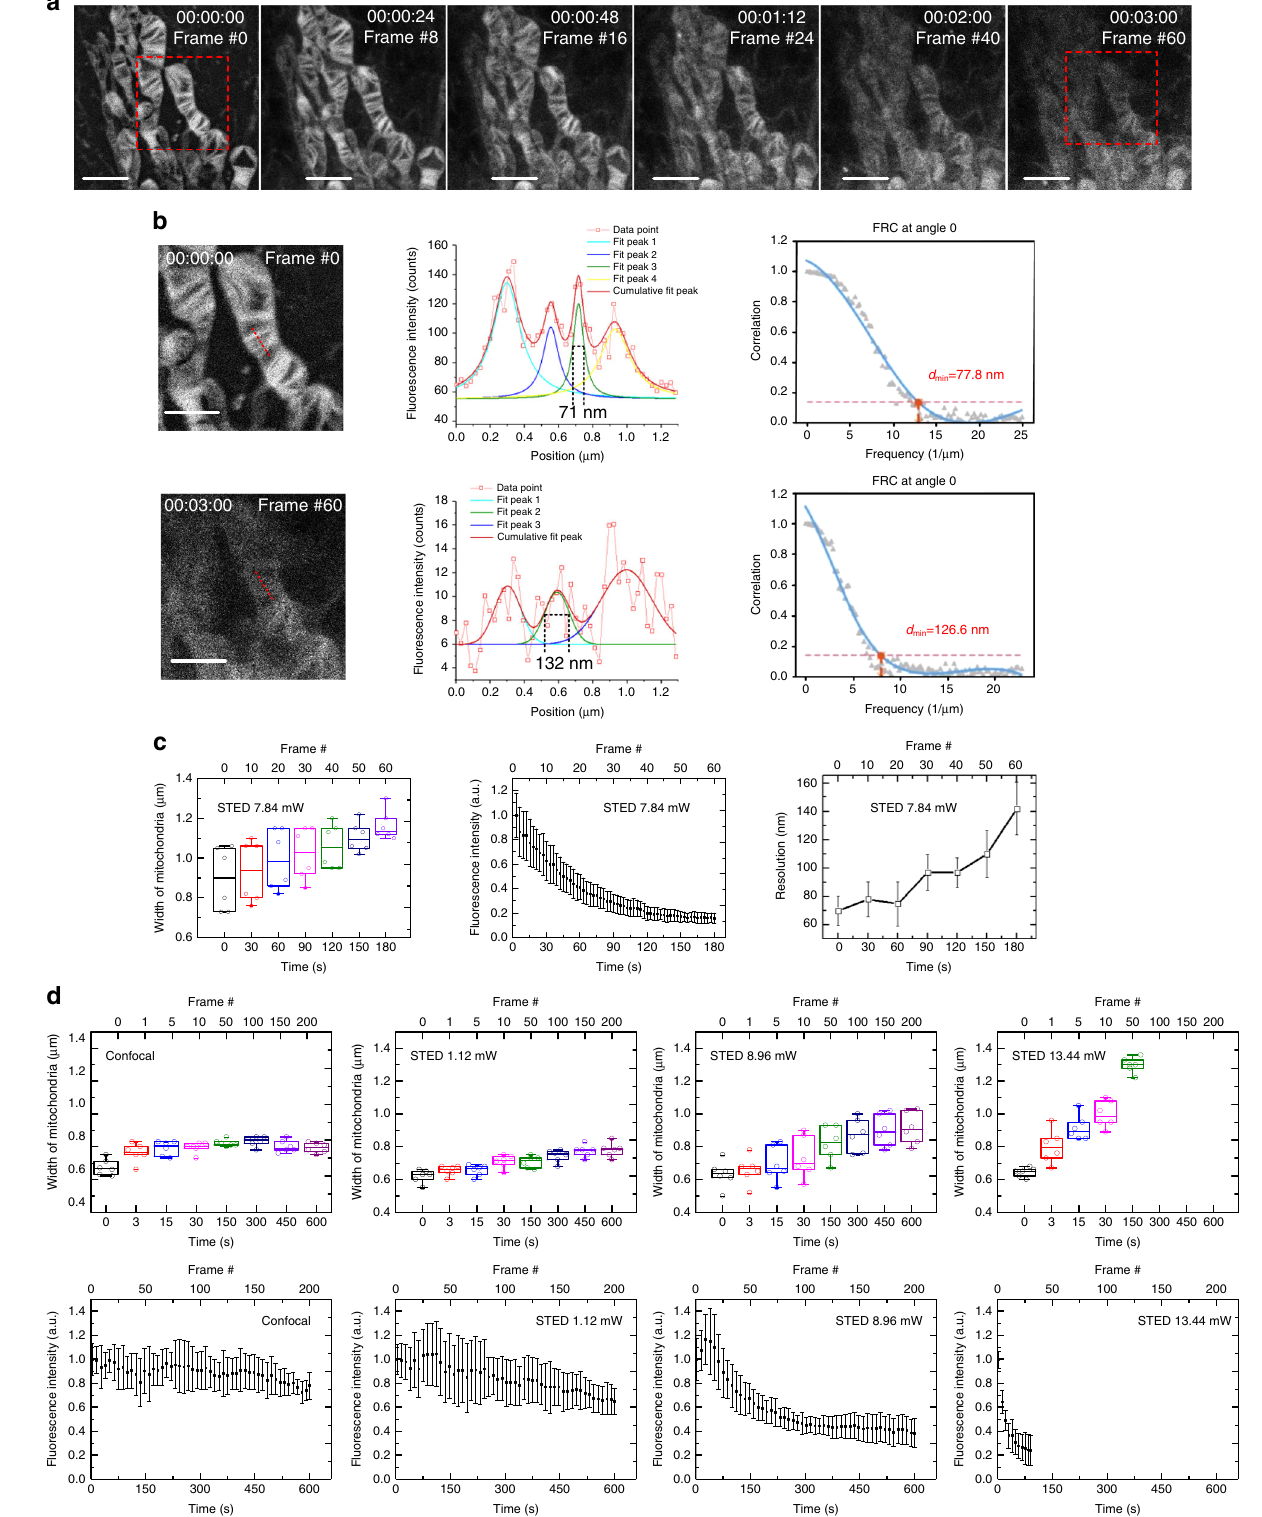
Fig. 3 STED imaging of mitochondrial cristae and the subsequent statistical analysis. a Time-lapse STED imaging of the mitochondria. Scale bar, 3 μ m. b The enlargement of the red box in a , cross-section intensity pro fi le at the red line and their FRC analysis results regarding the resolution 26 . Scale bar, 2 μ m. c Time-lapse plots of mitochondrial width, fl uorescence intensity and image resolution. d Changes in mitochondrial width and fl uorescence intensity under different STED intensities. Where box plots are shown, the centreline represents the median, the bounds of the box represent the upper and lower quartiles, the whiskers represent minimum and maximum values, and the hollow circle shows dot plots, n = 6. Error bars represent the standard deviation of the means, n =